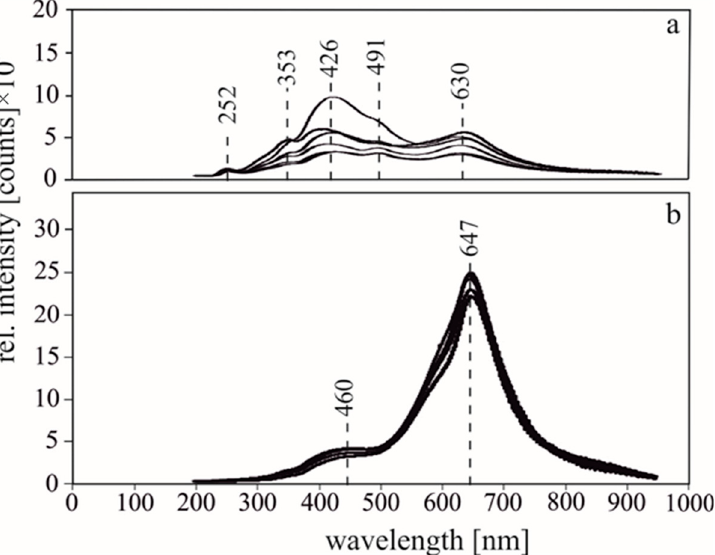
Figure 5. CL spectra of ballen quartz: ( a ) domains of type A and ( b ) domains of type